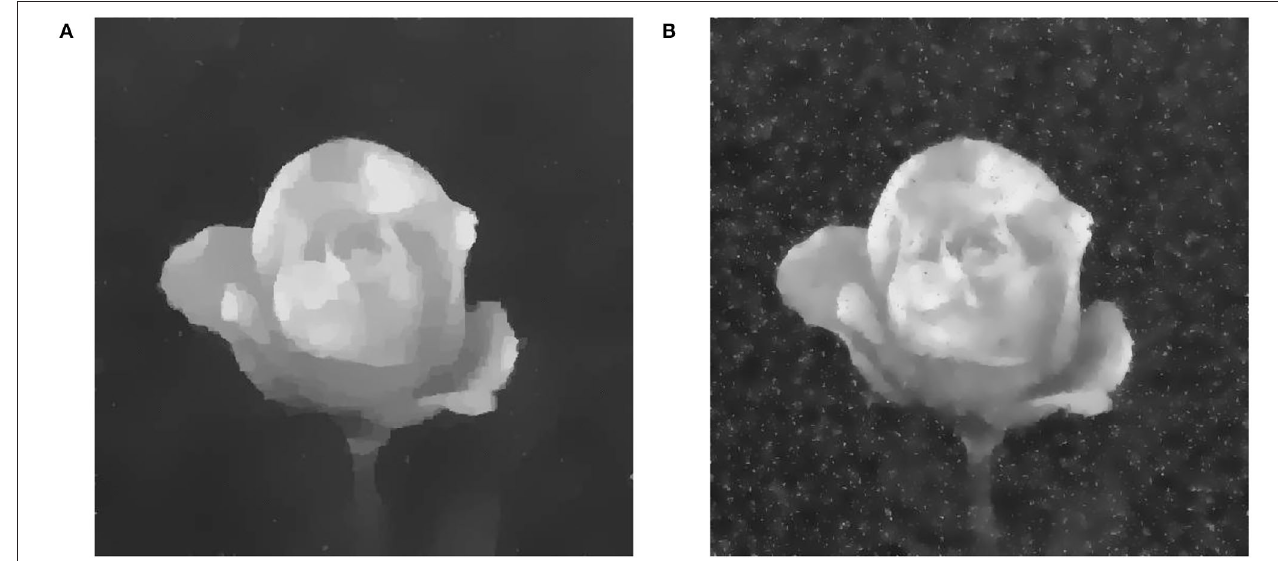
FIGURE 3 | Example of denoising results (A) is the ATV denoising image with µ = 0.01; (B) is the ATV denoising image with µ = 0.015.